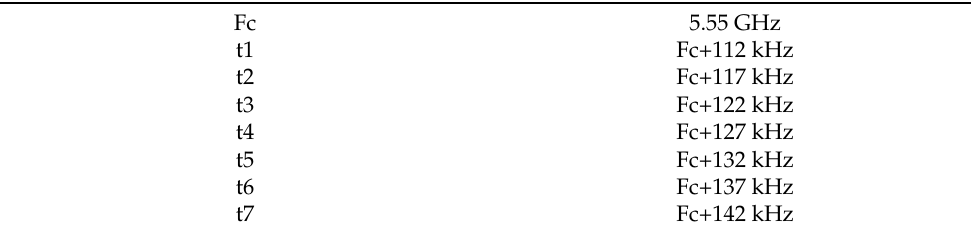
Table 1. Multi-sines frequencies used in each port of the 3D antenna array.